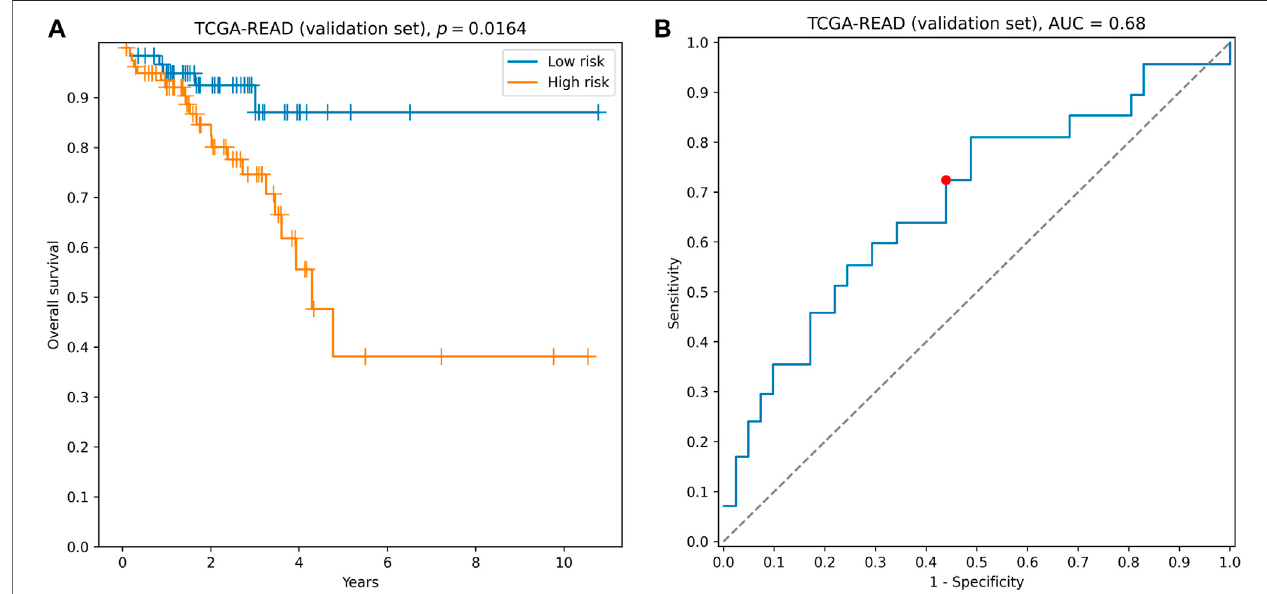
FIGURE 4 | Performance of AGRN, DAG1, FN1, ITGA5, THBS3, and TNC signature on the validation set. (A) Kaplan – Meier curves. (B) 3-year ROC curve. Red point on the ROC curve corresponds to the risk score threshold, calculated as a median score on the training set.